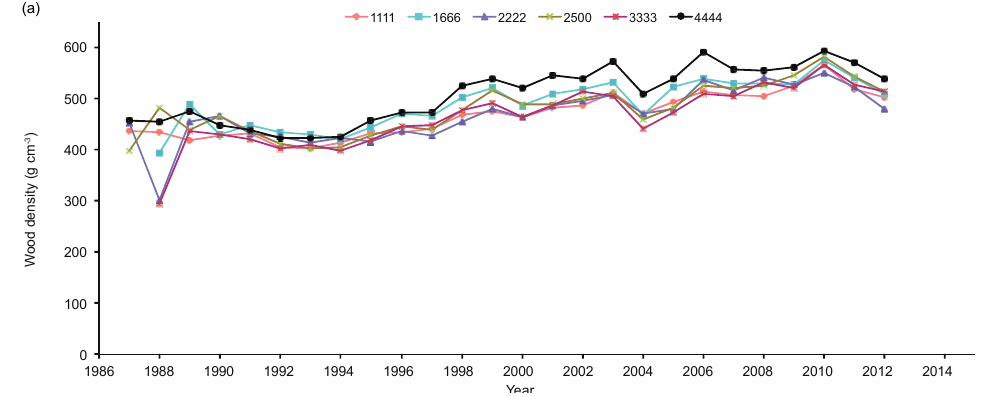
Figure 5. Annual wood density ( a ) and percentage of latewood ( b ) at different tree spacing for jack pine 25 years following planting in Quebec, Canada. 4. Discussion 4.1. Spacing and Tree Growth Plantation spacing is known to influence tree growth and the morphology of individual trees [44]. In this study spacing had a significant impact on the DBH, but not on tree height. McEvoy [45] and Cardoso et al. [4] already reported/stated that spacing did not affect the height growth of dominant stems in Pinus taeda , probably because the tree densities were too low to create a high enough level of light competition to impair height growth. In our study, stem height inside each plot varied less than 1.5 m due to the selection of only dominant trees, suggesting light accessibility was similar between trees. If suppressed, co ‐ dominant, and dominant trees had been selected, spacing would likely have influenced not only height growth but also tree mortality [46]. However, several authors reported a significant increase in diameter growth for different trees species in plantations with a low number of trees per hectare, due to a better tree crown development [2,47]. Contrary to our hypothesis, and to Sharma and Parton [48] who found an important decrease of stem diameter with tree height in jack pine, the plantation spacing gradient from 1111 to 4444 trees per hectare did not affect the taper of the jack pine stems 25 years after plantation. It seems that the DBH increase was not sufficient to change the stem taper. By looking at the chronosequence of DBH growth, the narrowest and widest plantation spacings differed from the intermediate ones starting from the planting age of seven years. These differences lasted only a limited period of time. As the study site is located at the northern limit of the eastern yellow birch/balsam fir bioclimatic sub ‐ domain [30] and on humo ‐ ferric podzols, the growth conditions can be considered to be